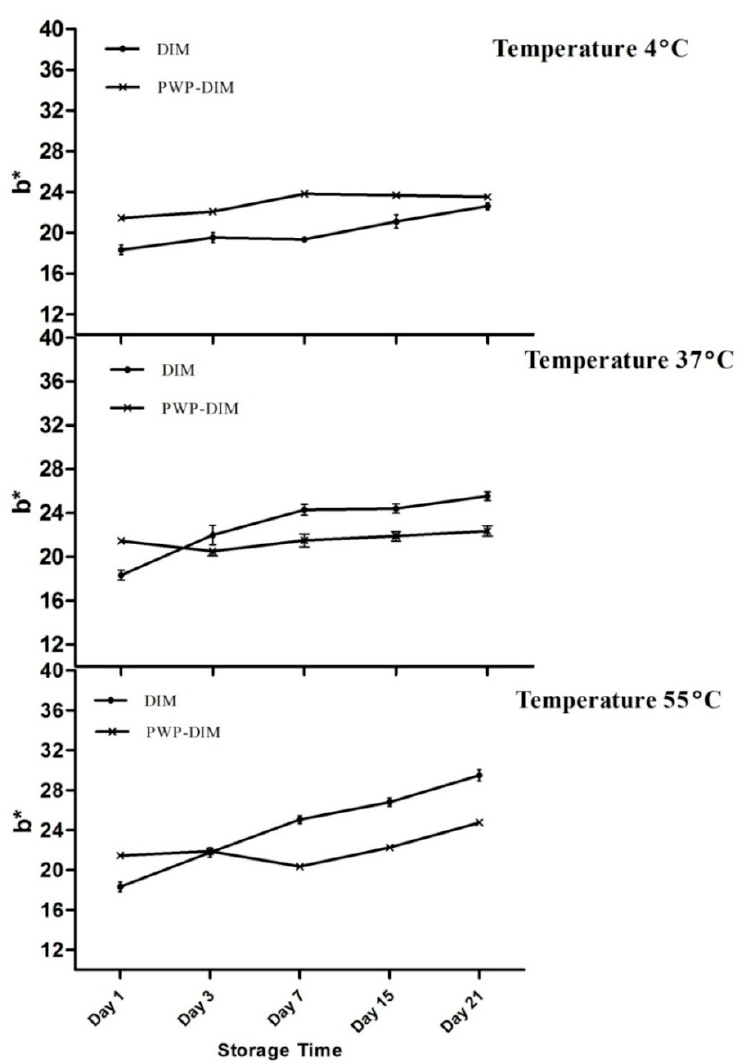
Figure 5. Effect of storage temperature (4, 37 and 55 °C) blue-yellow axis (b*-value) of DIM, and PWP/DIM with mass ratio (5:1) nanoparticles during storage. Values are mean ± SD ( n = 3).